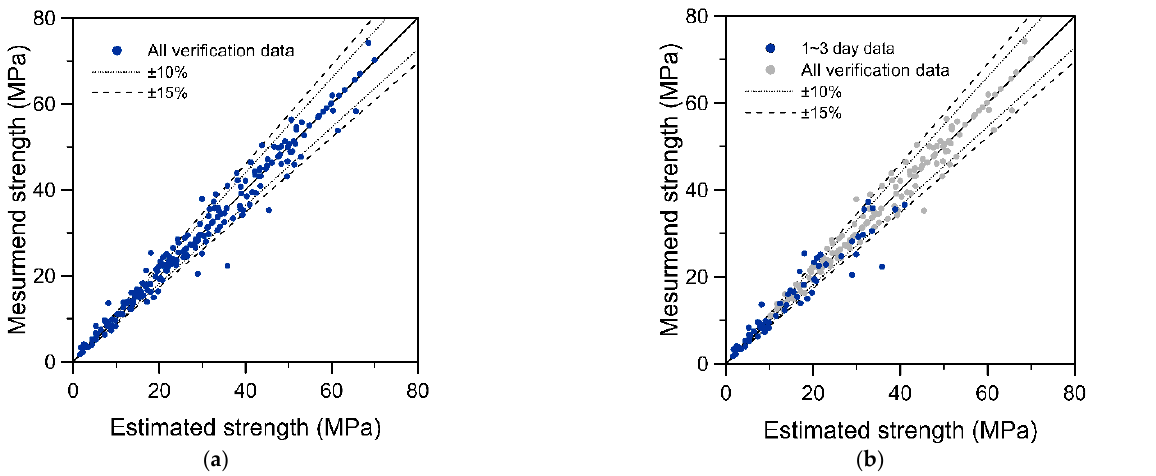
Figure 10. Comparison between the concrete strength measurements and estimations made using the unified equation: ( a ) estimation results of concrete at all ages; ( b ) comparison of the estimation results within 3 days of setting and at all ages.